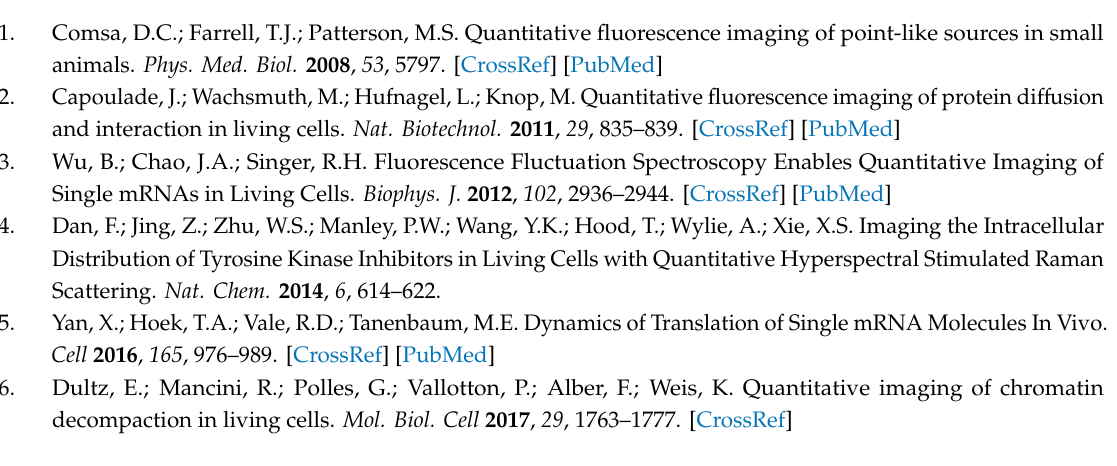
Figure 9. The signal-to-noise ratio (SNR) variation of BGERTs-based SERS imaging in different exposure times.